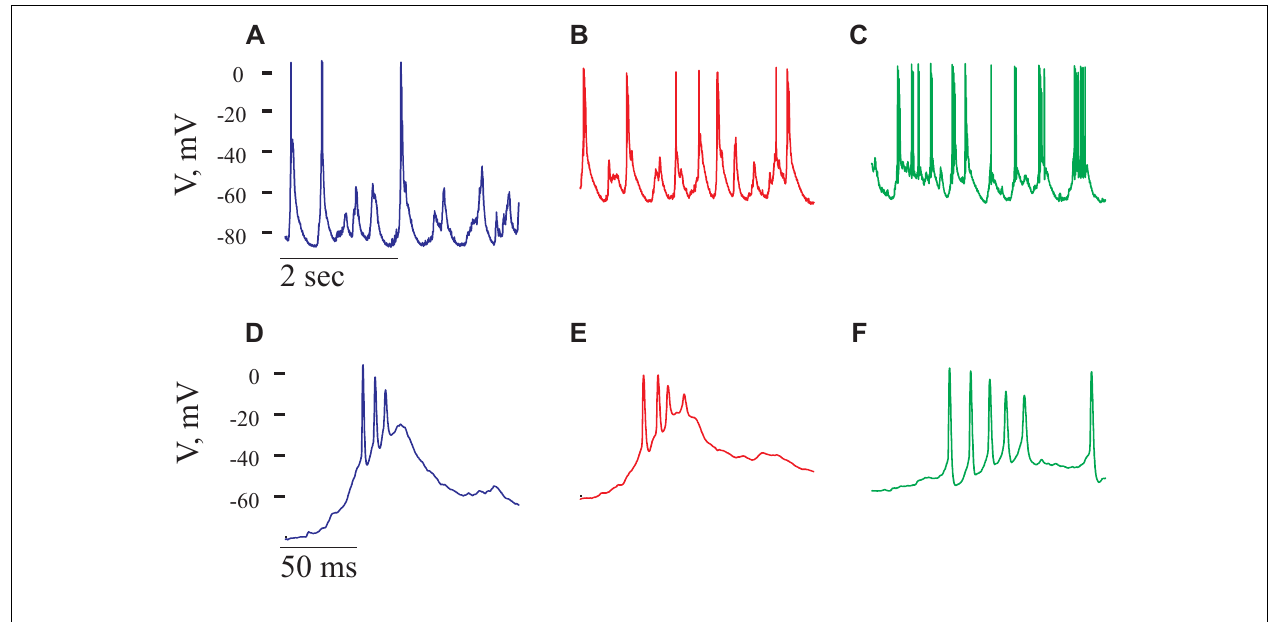
FIGURE 8 | Paroxysmal depolarizing shift, PDS, recorded in the presence of Gabazine. All panels refer to data from the same cell after administration of gabazine (2.5 mM). (A–C) voltage traces recorded at three holding potentials